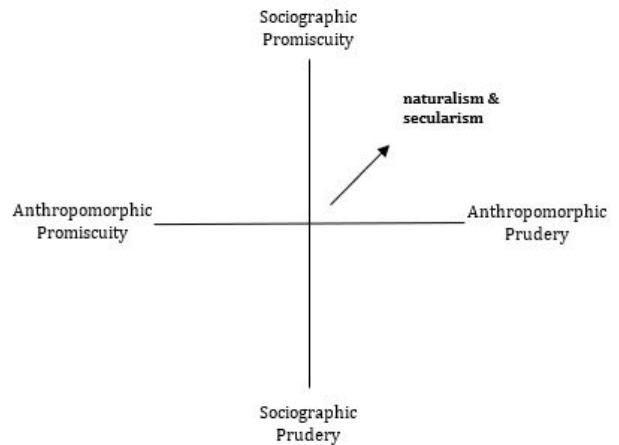
Figure 4. Naturalism and secularism as theolytic (god-dissolving)